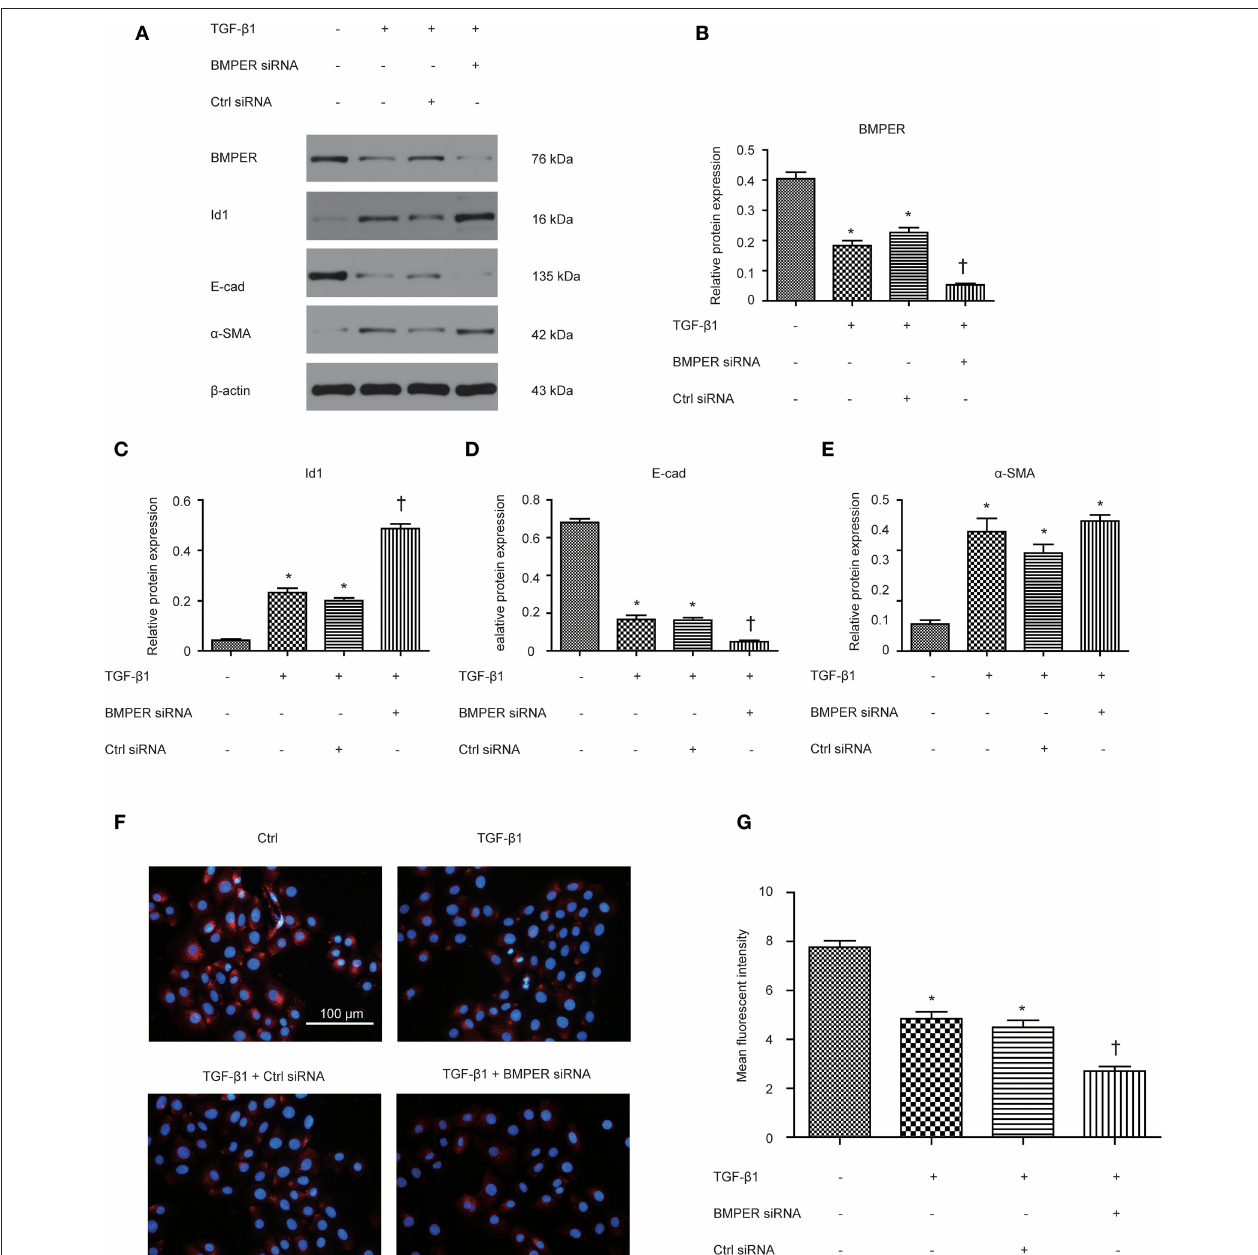
FIGURE 2 | BMPER knockdown aggravated TGF- β 1-induced dedifferentiation in HK-2 cells. BMPER, Id1, E-cadherin and α -SMA were measured by Western blot after HK-2 cells with different treatments (A) . The relative protein expression for BMPER, Id1, E-cadherin and α -SMA in HK-2 cells was displayed (C–E) . Values are the means ± SEM ( n = 3). Representative photographs of the E-cadherin visualized by indirect immunofluorescence staining in HK-2 cells after various treatments (F) . Graphic presentation of mean fluorescent intensity in various groups (G) . Scale bar = 100 µ m.* p < 0.05 vs. control; † p < 0.05 vs. TGF- β 1 group.